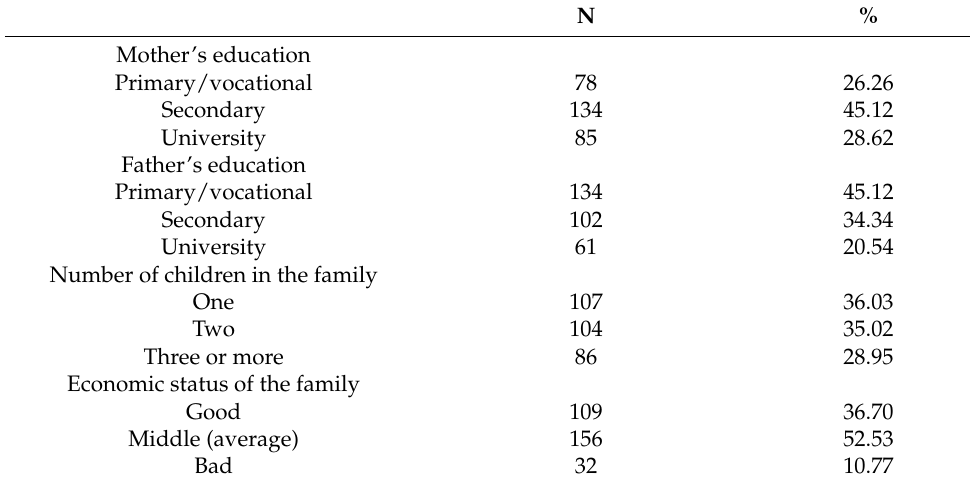
Figure 1. Flow chart of the study group and its division according to the size at birth and the occurrence of catch-up growth. Table 1. The socioeconomic status of studied